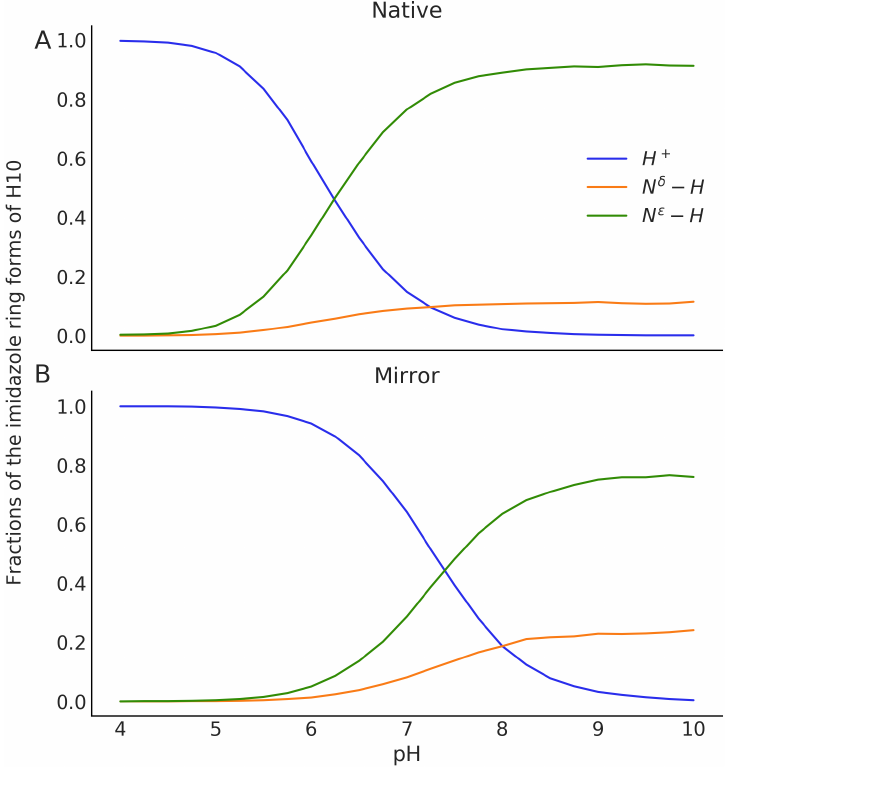
Figure 4 Fractions of the imidazol ring forms of H10 as a function of pH, for the ‘‘Native’’ (A) and ‘‘Mirror’’ (B) topologies of the Q10H mutant of protein A. The values, for each topology, are estimated along 25 ns MD equilibrium trajectory for each of nine ionization states of two electrostatically-coupled histidines residues, namely H10 and H19. Full-size DOI: